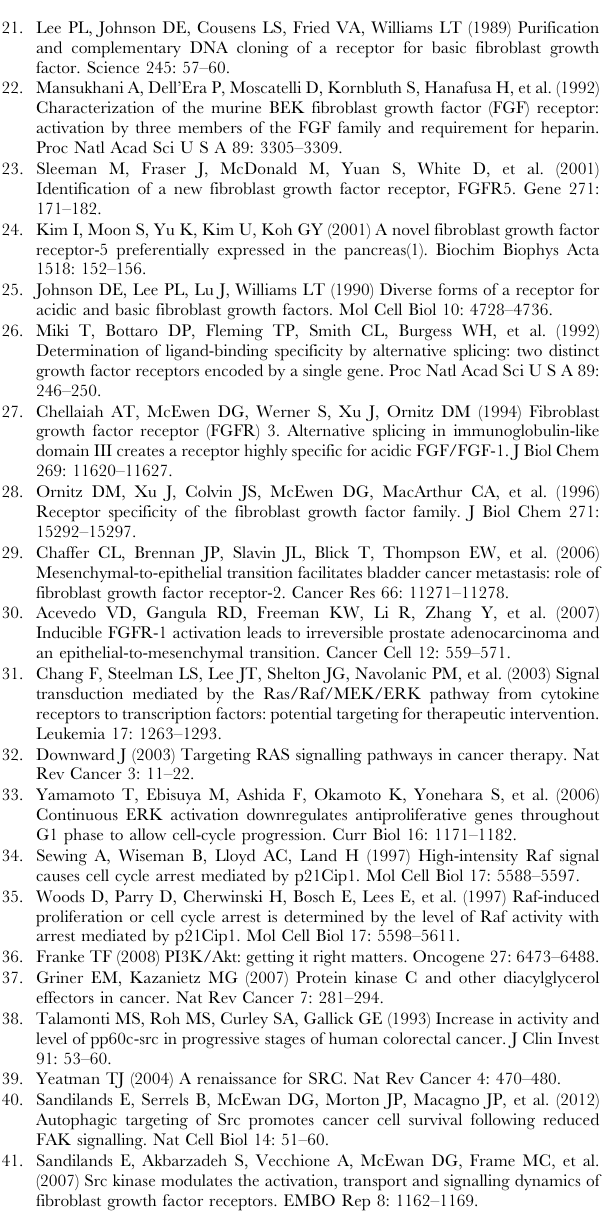
Figure S1 Y1 cells express FGFR1, FGFR2, FGFR3 and FGFR5. This figure shows the s equencing of PCR fragments harboring the splicing sites between IgIIIa and IgIIIc of FGFR1, FGFR2 and FGFR3 in Y1 cells. Figure S2 FGF2 delays S phase entry and irreversibly restrains cell division. Flow cytometry histograms of DNA content in Y1 cells after FCS (10%) and FGF2 (10 ng/mL) treatment in G0/G1-starved cells begun at 0 h. Samples were taken at the indicated time points (12, 24, 36, 48 and 60 h